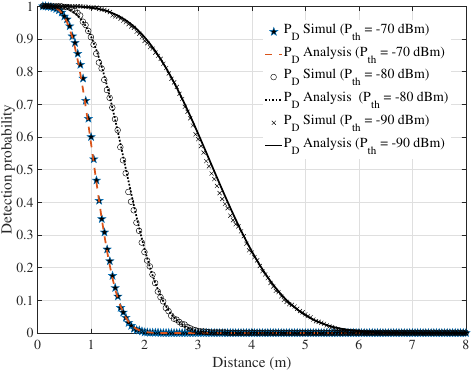
Figure 4. Detection probabilities of the system under different threshold levels of receiver